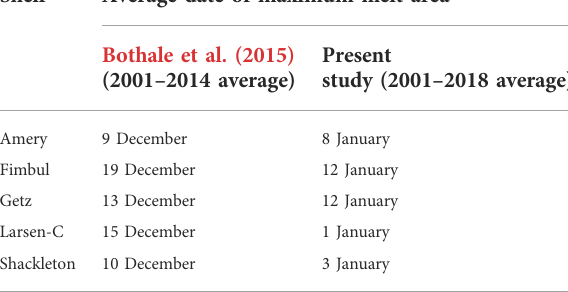
TABLE 2 Comparison of maximum surface snow melt area with the earlier study done on Antarctic ice